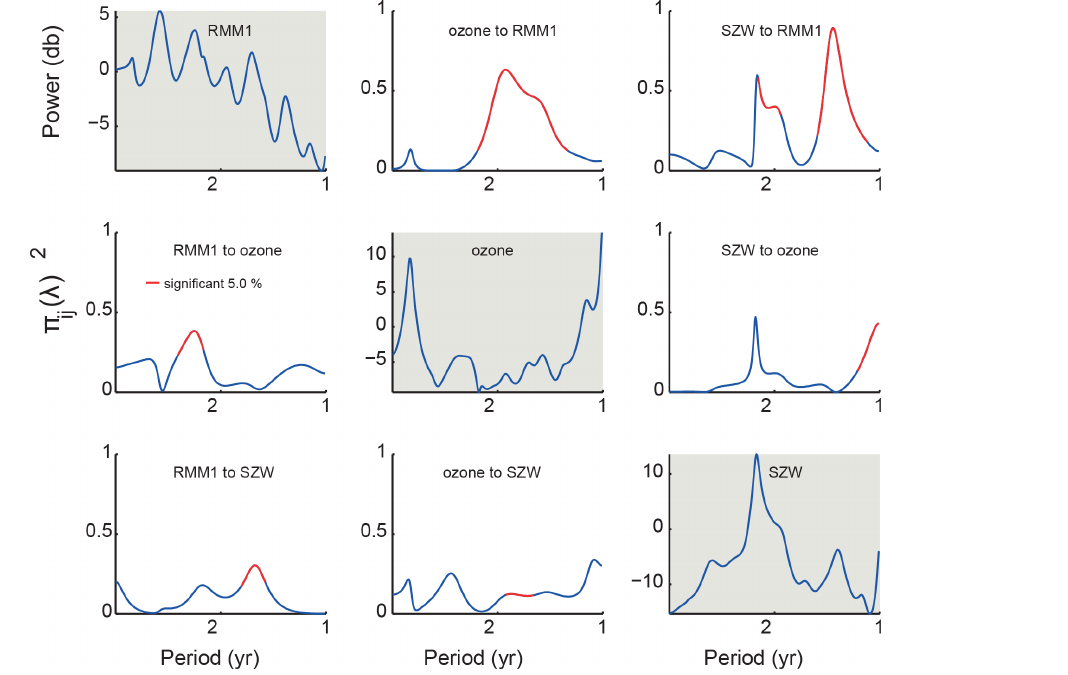
Figure 3. PDC analysis between the MJO and stratospheric zonal wind (SZW) at the slow ( > 1-year periods) timescale. Results indicate significant interaction on annual–biennial timescales. Figure conventions are the same as in Fig.